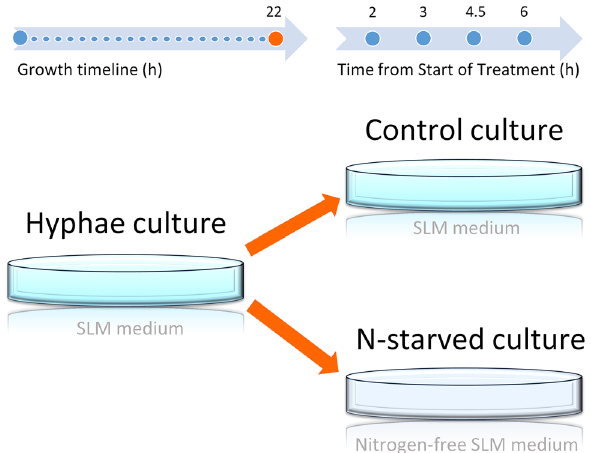
Figure 1. The outline of experimental design of nitrogen starvation. Hyphae cultures are grown in control conditions (Control culture) or in nitrogen-depleted medium (N-starved culture). Time points of sampling are marked as blue dots.